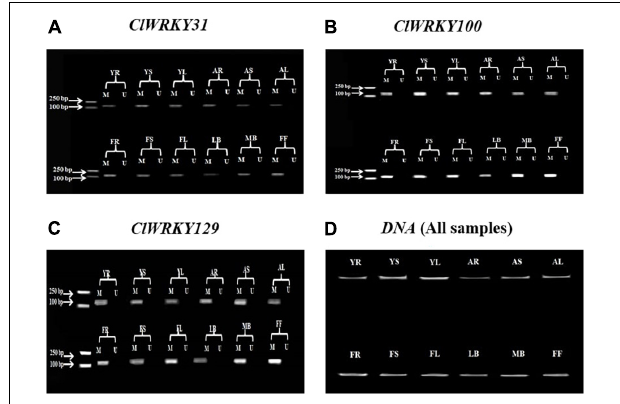
FIGURE 5 | ClWRKY31, ClWRKY100 , and ClWRKY129 Methylation-Specific Polymerase Chain Reaction (MSP) results (A–C) . An MSP was conducted to determine the methylation status of selected genes. The PCR product length of the genes was as follows: ClWRKY3 1 = 156 bp, ClWRKY100 = 135 bp, and ClWRKY129 = 131 bp. “M” represents a methylated PCR product, and “U” represents an unmethylated PCR product. (D) The genomic DNA results for all samples. These results were verified through gel (1.5%) electrophoresis. The abbreviations of different growth stages and tissues are as follows: